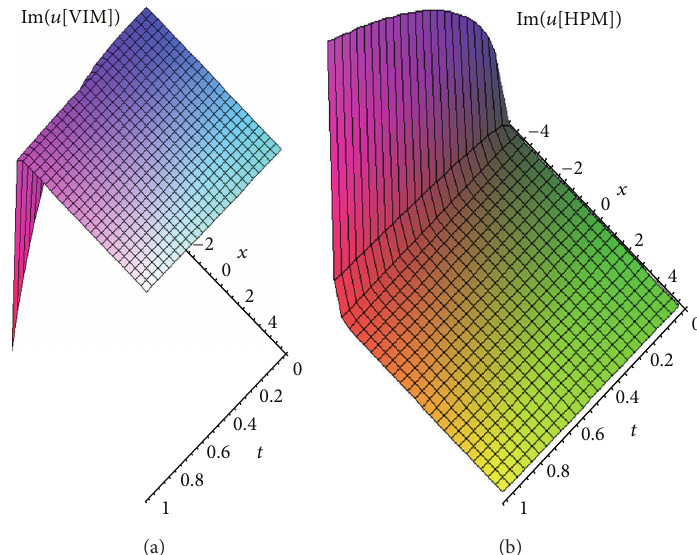
Figure 3: The imaginary part of the approximate solution obtained by the variational itearation method (38) shown in (a) in comparison with that of the approximate solutions obtained by homotopy perturbation method (32) shown in (b) when 𝛼 = 0.2 , 𝛽 = 0.4 , −5 < 𝑥 < 5 , and 0 < 𝑡 < 1